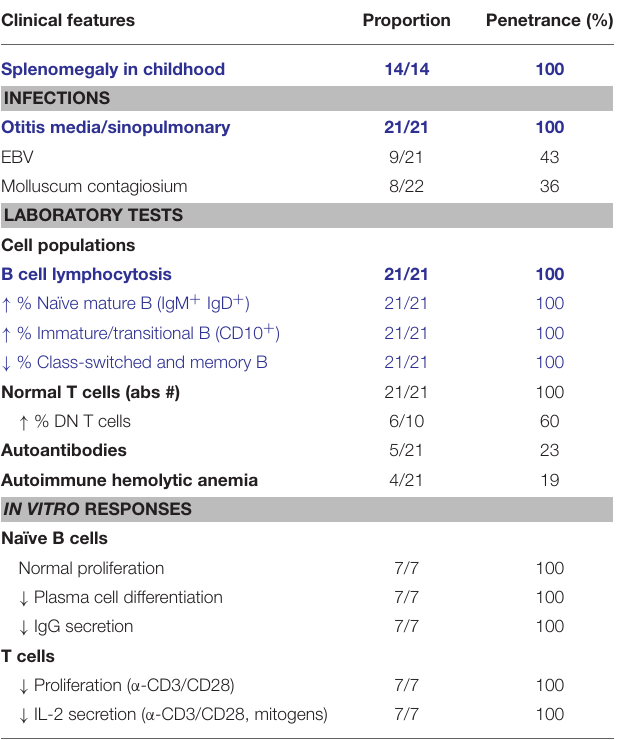
TABLE 5 | “Red flags” suggestive of BENTA disease (GOF CARD11 mutations). Clinical